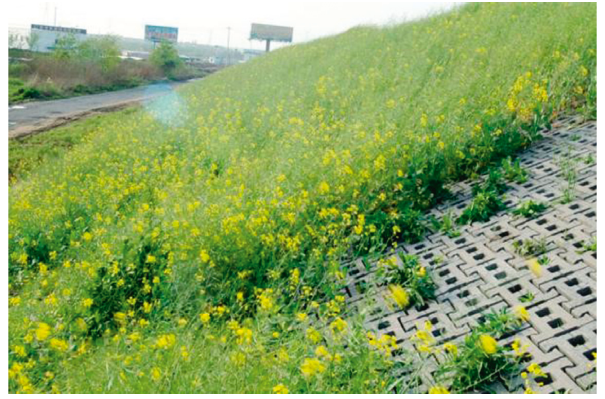
Figure 1: The anchor + hinged block ecological slope protections in